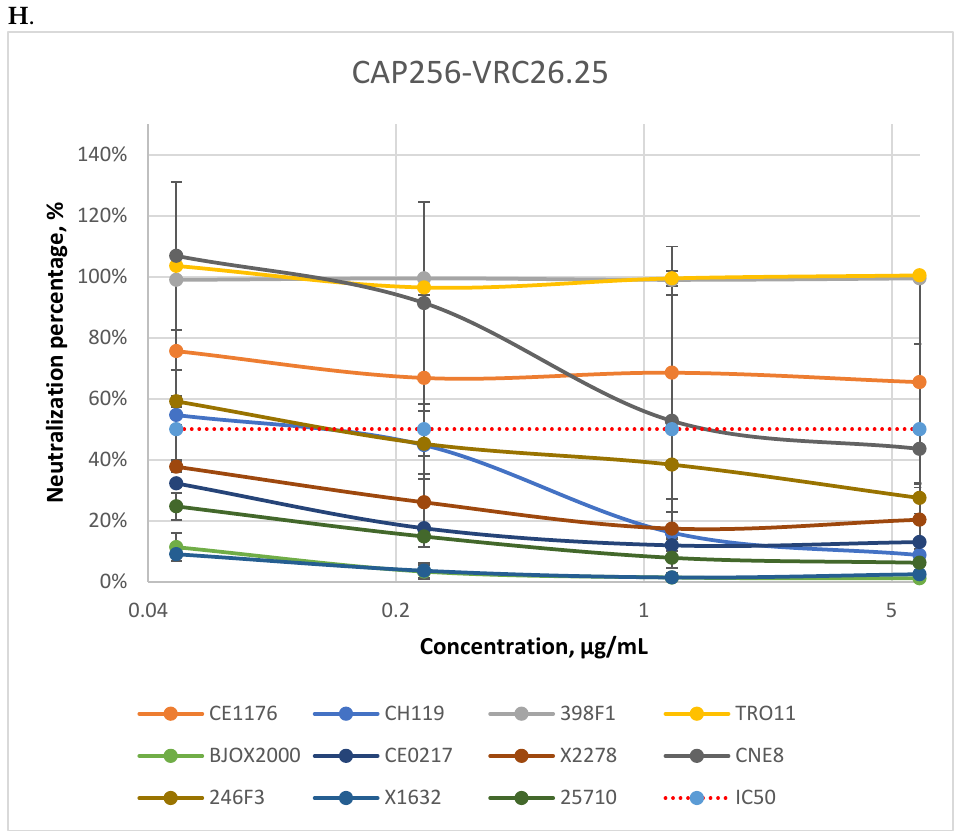
Figure A2. Pseudoviruses neutralization curves for bNAbs ( A – H ) (n = 2, ±SEM, on the Y-scale, 100% means no neutralization and 0%—complete neutralization).